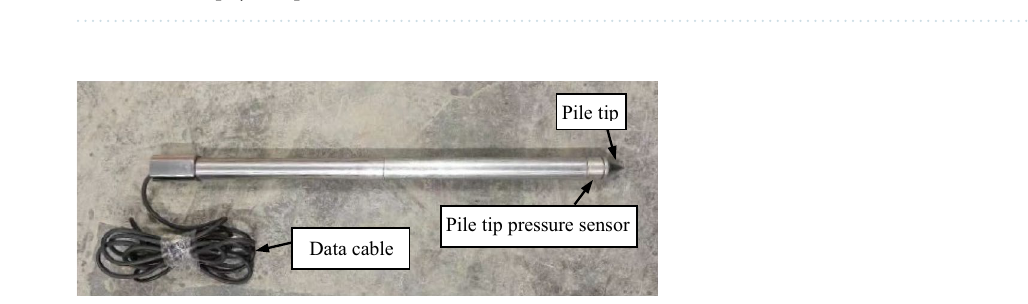
Table 1. Basic physical parameters of soil.